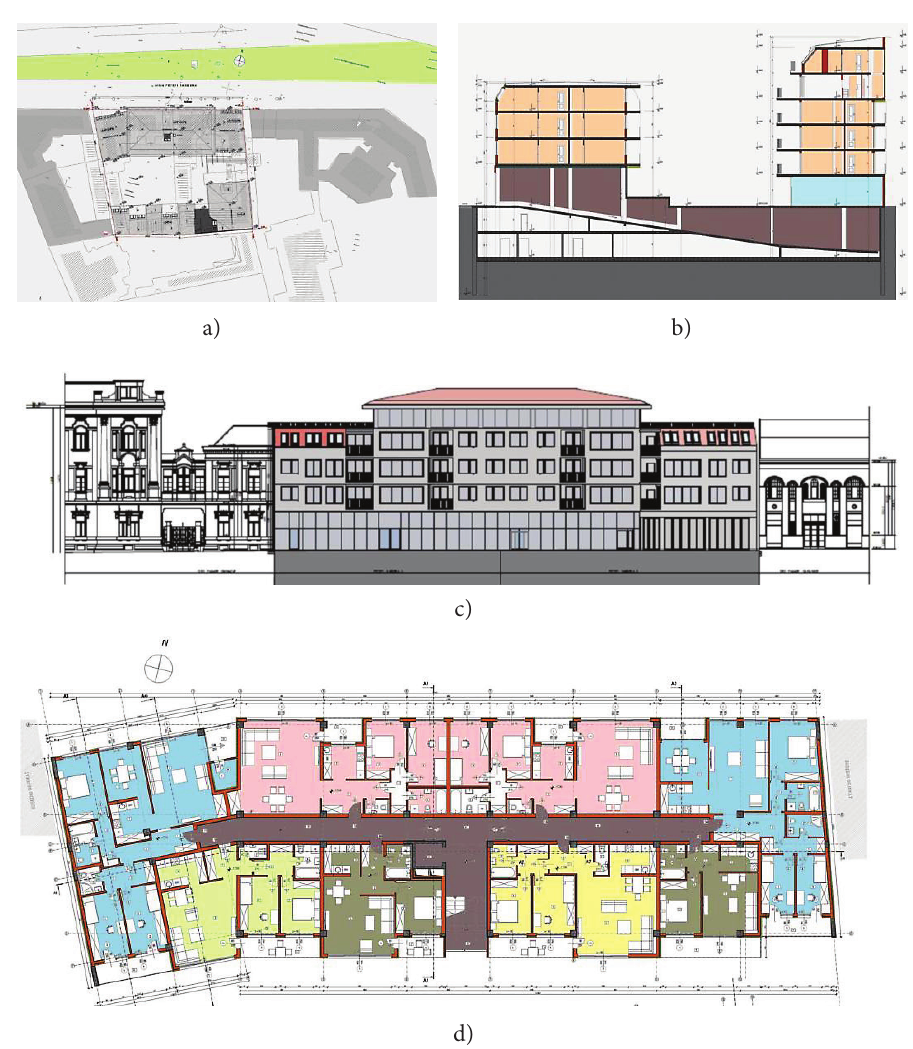
Figure 4. Initial project for reconstruction by DG (source: Competition. 2016); a) Situation plan; b) Cross section; c) Petefi SandorStreet view; d) Plan of typical